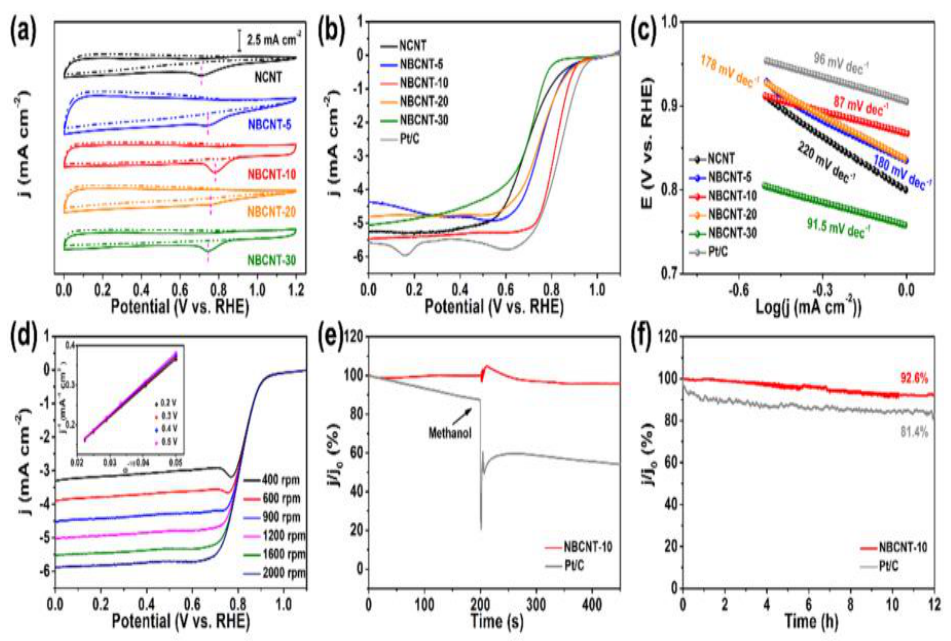
Figure 13. Catalytic performance of ORR in 0.1 M KOH electrolyte. ( a ) CV curves of different electrocatalysts in N 2 -saturated (dashed curve) and O 2 -saturated (solid line) alkaline electrolytes. ( b ) LSV curves for a fixed speed of 1600 rpm and a voltage of 10 mV s − 1 ( c ) Tafel plots for NCNT, NBCNT-5, NBCNT-10, NBCNT-20, NBCNT-30, and commercially available Pt/C catalysts obtained by applying mass transfer correction to the corresponding LSV curves. ( d ) LSV curves and K-L plots for NBCNT-10 at various rpm from 400 rpm to 2000 rpm (inset). ( e ) Methanol tolerance of NBCNT-10 and Pt/C. ( f ) i-t chronoamperometry response. (Reprinted with permission from [179]. Copyright 2021, Elsevier).